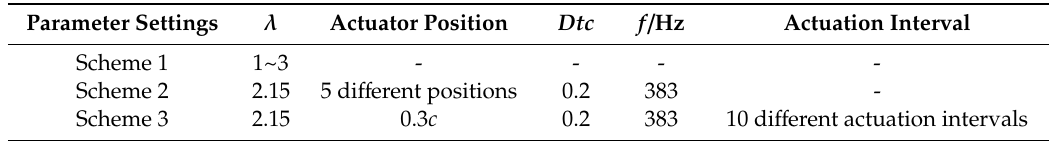
Table 1. Parameters of the simulations.